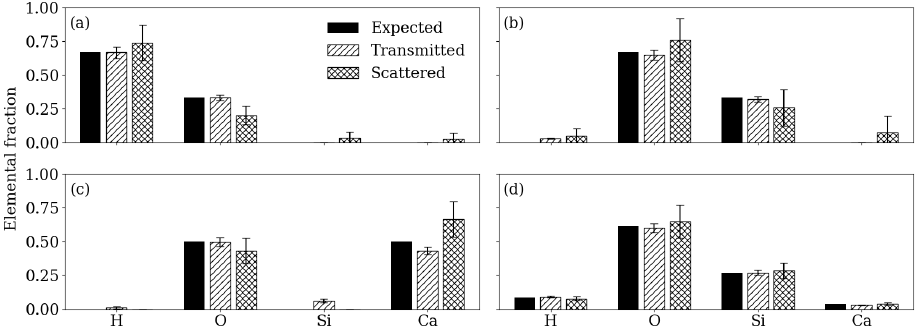
Fig. 6. Elemental fractions of H, O, Si and Ca unfolded from either the transmitted or scattered signatures for (a) H 2 O, (b) SiO 2 , (c) CaO, and (d) sand. In each case, the known ratio (black) is included for comparison. Table 2. Difference between expected and unfolded elemental ratios for transmitted ( Δ ! ) and scattered ( Δ " ) analyses for the case of